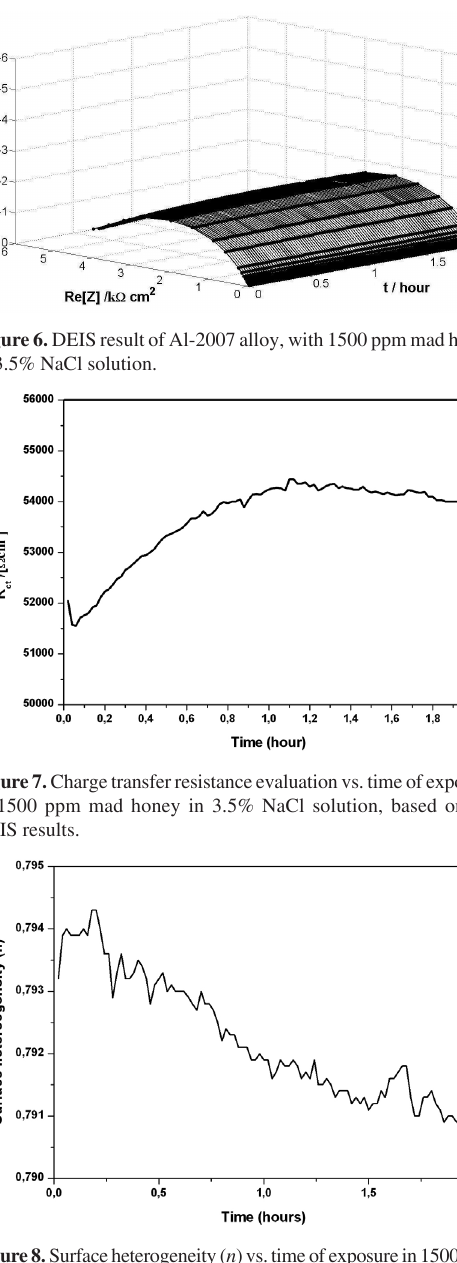
Figure 5. DEIS result of Al-2007 alloy in 3.5% NaCl solution.